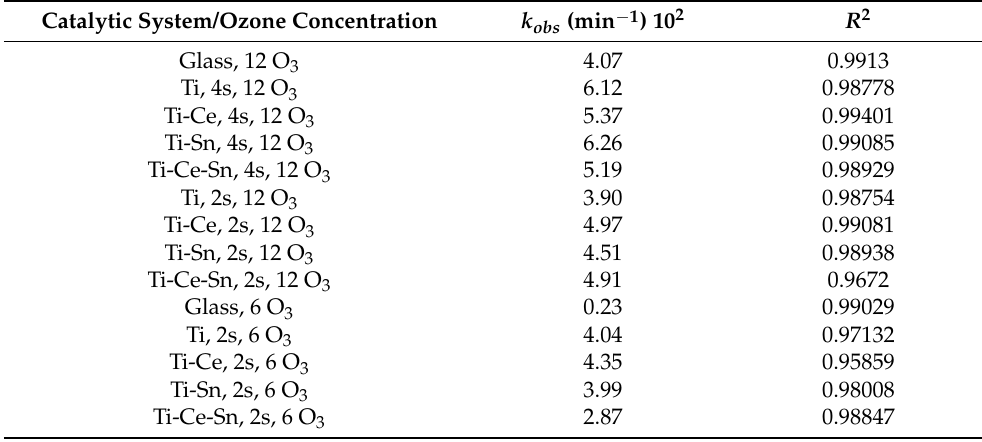
Table 4. Kinetic parameters for the paracetamol oxidation in different experimental